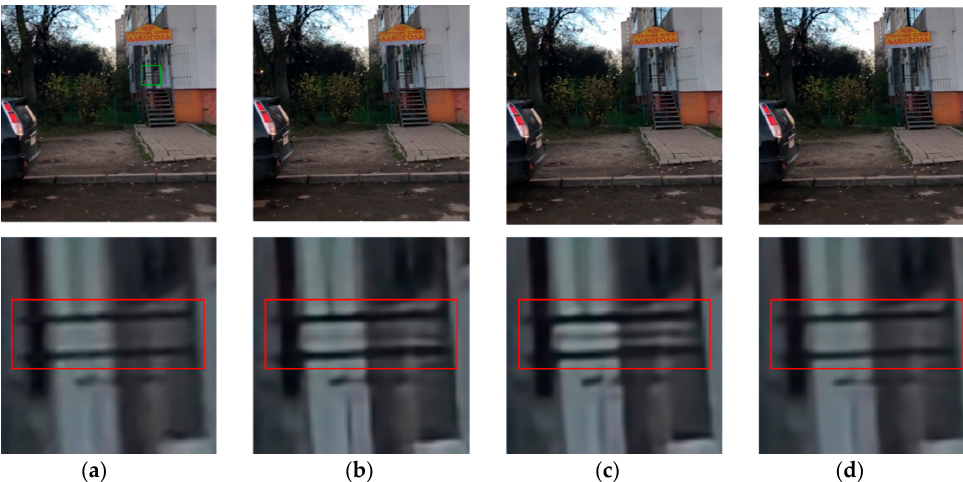
Figure 17. Deblurred results for three deep learning methods performed on the GoPro test image with 17 × 17 Gaussian blur kernel of deviation 2.2. The first row shows the sharp image and deblurred images by the evaluated methods. The second row shows the enlarged views of the region marked with green box in the original image and the deblurred images. ( a ) original image [39]; ( b ) SRN; ( c ) DPDNN; ( d ) proposed method.